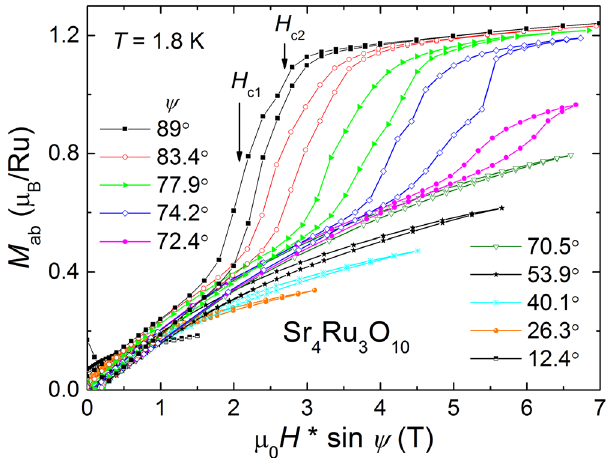
Figure 3. ab -plane magnetization M ab as a function of H ab = H sin ψ is shown for selected angles ψ between 89° and 12.6° measured at 1.8 K. A clear double step is observed at H c 1,2 as labeled by arrows for ψ = 89°.